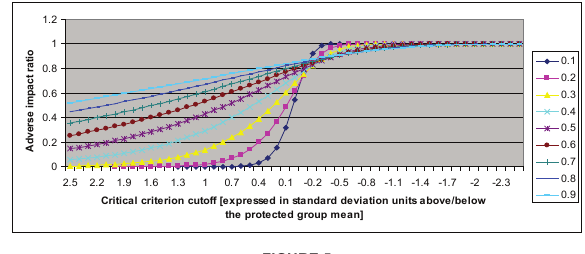
FIGURE 5 Adverse impact ratio as a function of the selection ratio and validity coefficient [difference in mean predicted criterion performance: 0,2 standard deviation units]